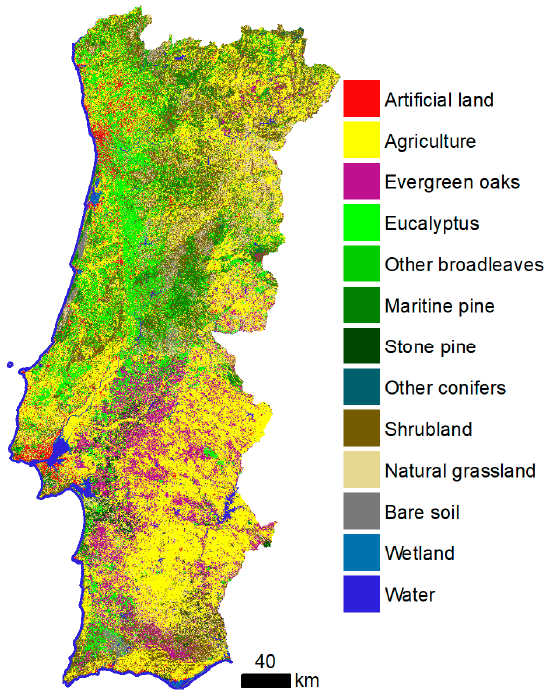
Figure 4. Land cover map of 2018.